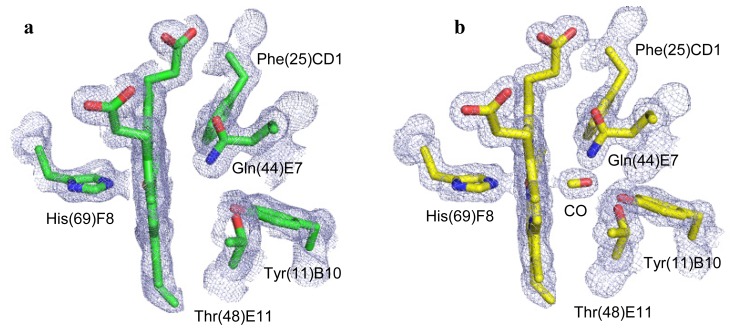
A view of the heme cavity in (a) unligated-CerHb, and (b) CerHb-CO, including distal and proximal sites, and the 2Fo-Fc electron density (blue mesh, contoured at 1σ level) calculated at the end of the refinement process. Residues lining the heme pocket are shown in ball-and-stick representation (unligated-CerHb in green and CerHb-CO in yellow, respectively). The heme is seen edge on; the distal cavity is on the right of the heme.